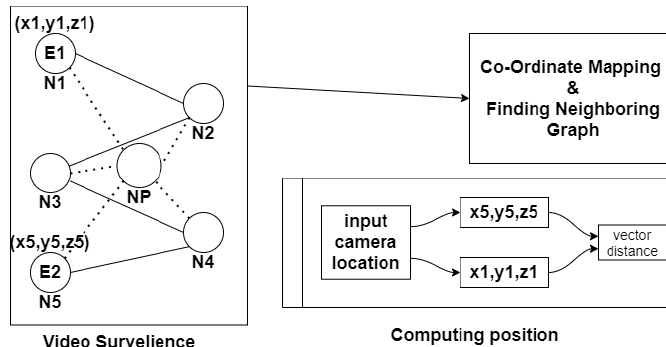
fig 4: camera interacting with each other passing the features from one node to